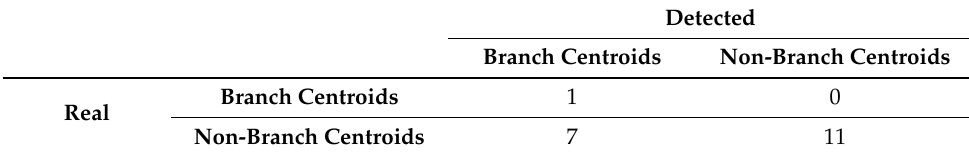
Table 5. The confusion matrix of real and detected branch centroids using the maximum entropy